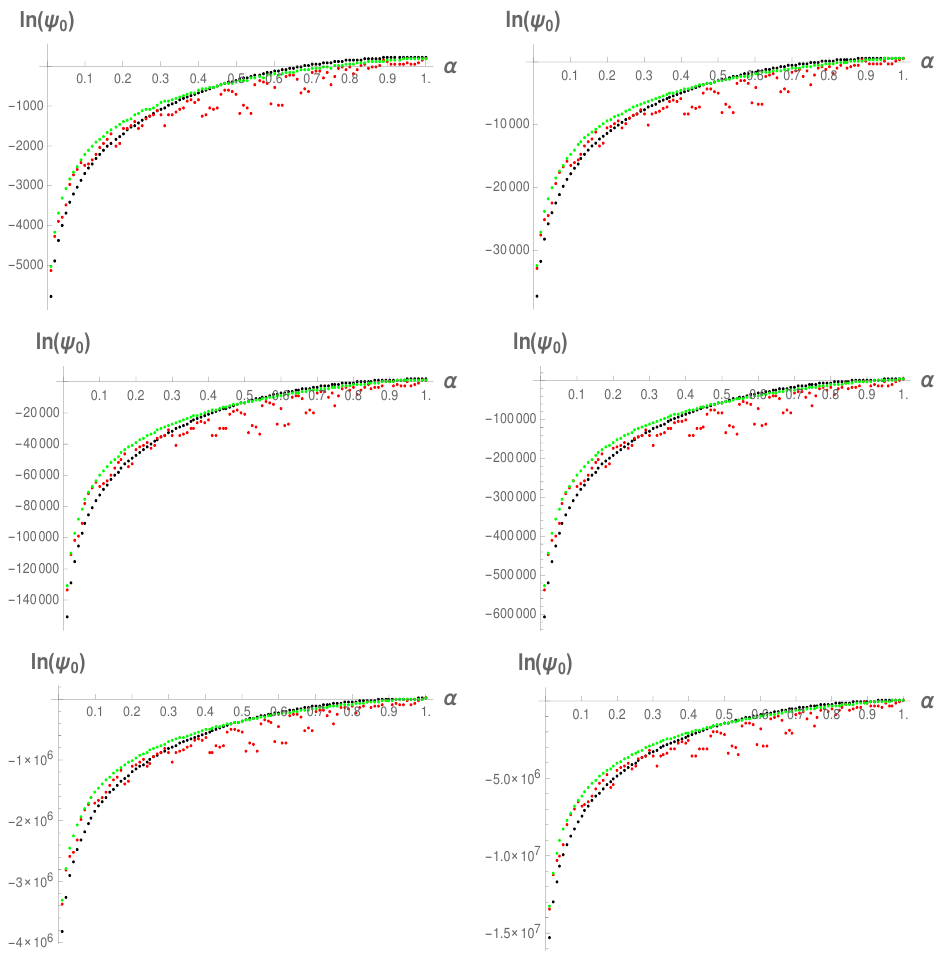
Figure 4 . Comparison of the estimator in subsection 6.3 (red) with a discretization into 25 parts versus ln( #(cid:1)(cid:1)(cid:1)# ) (green) and the exact matrix elements ln( 0 ) calculated using the Vandermonde formula (2.14) (black) at N = 100 (top left), N = 250 (top right), N = 500 (middle left), N = 1000 (middle right), N = 2500 (bottom left) and N = 5000 (bottom